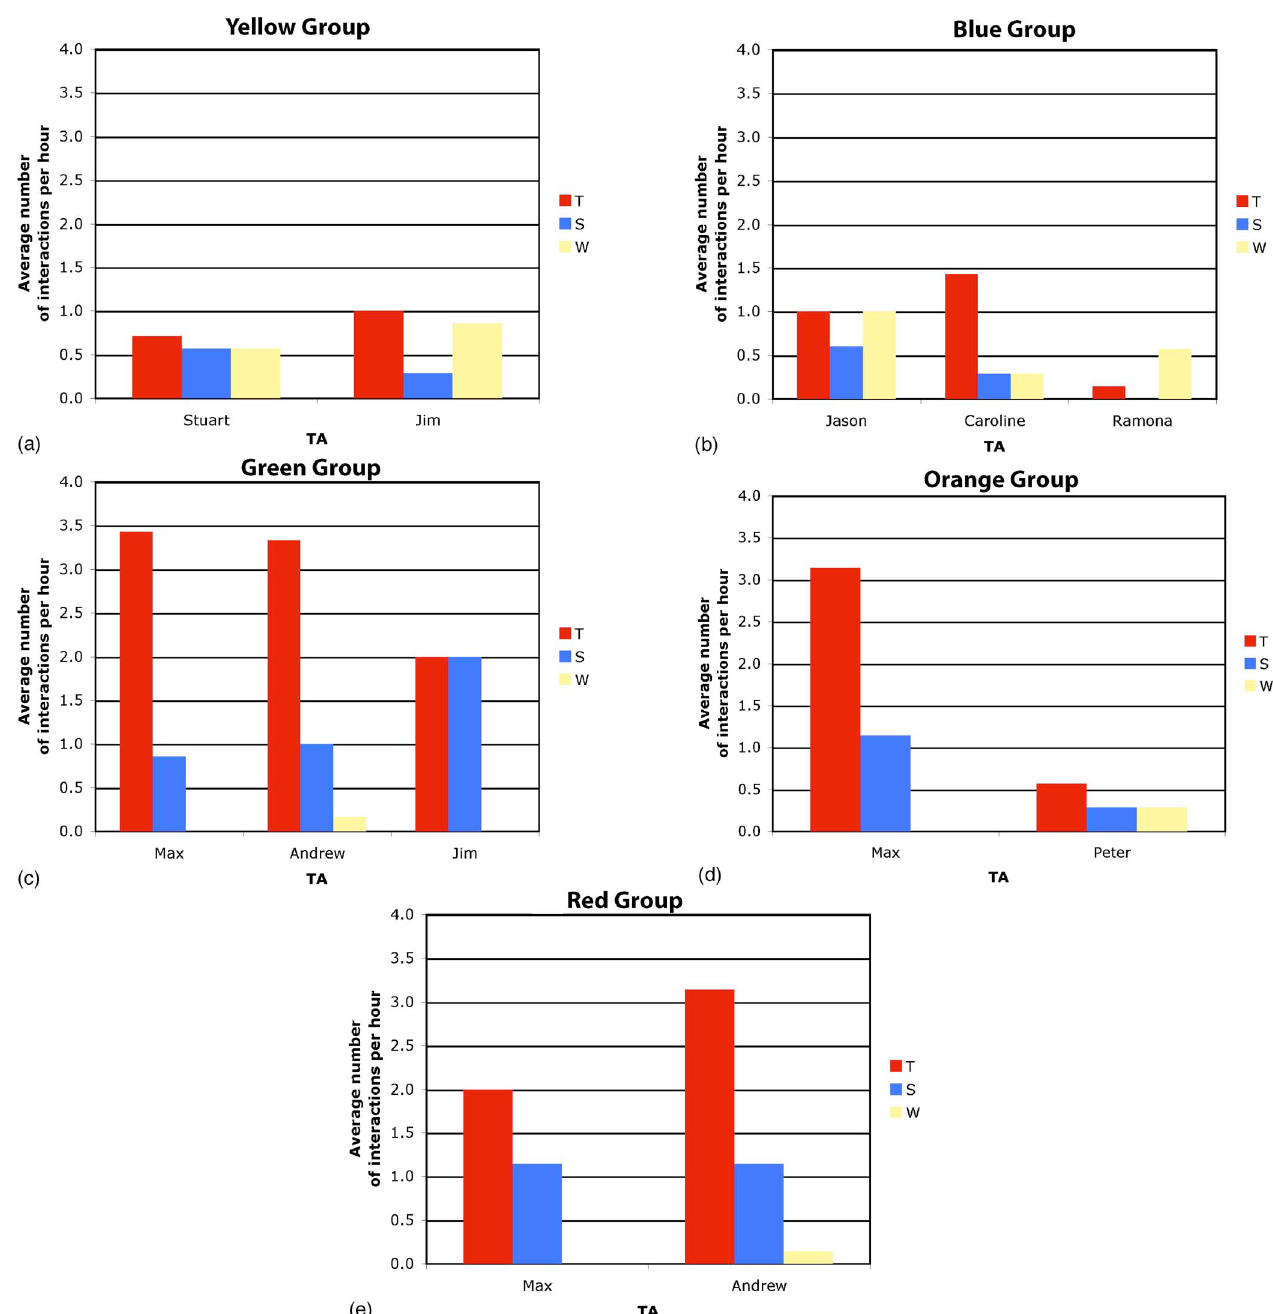
FIG. 5. (cid:1) Color (cid:2) (cid:1) a (cid:2) The yellow group’s interactions with Stuart and Jim. (cid:1) b (cid:2) The blue group’s interactions with Jason, Caroline, and Ramona. (cid:1) c (cid:2) The green group’s interactions with Max, Andrew, and Jim. (cid:1) d (cid:2) The orange group’s interactions with Max and Peter. (cid:1) e (cid:2) The red group’s interactions with Max and